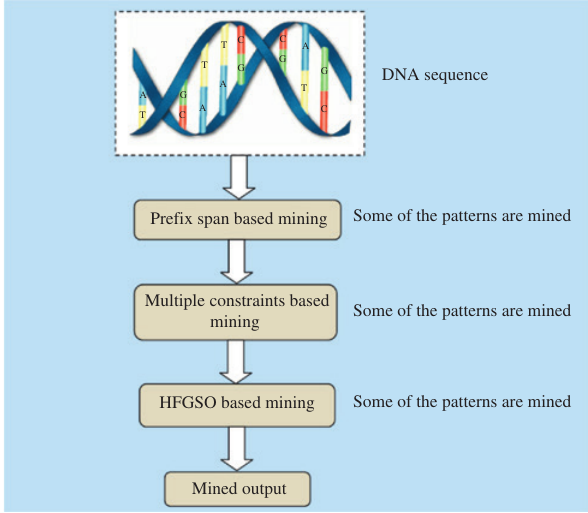
Figure 1: Overall Diagram of the Proposed DNA Sequence